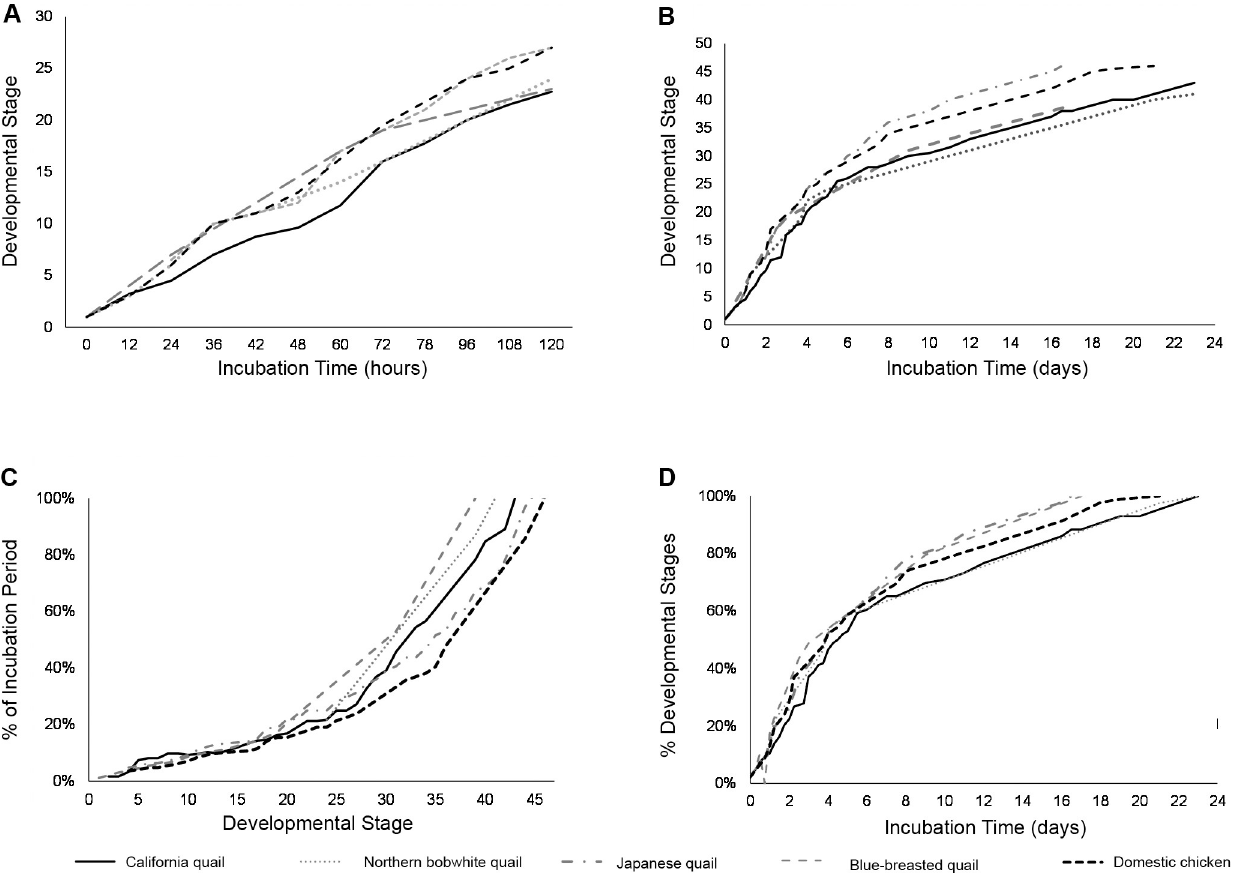
Fig 12. Comparisons of developmental stages of California quail, northern bobwhite quail, Japanese quail, blue-breasted quail, and domestic chicken embryos. (A) Stages for the first 5 days of development. (B) Stages for entire incubation period ( � 23 days). (C) Comparison of stages and percentage of total incubation time. (D) Comparison of stages and of percentage of